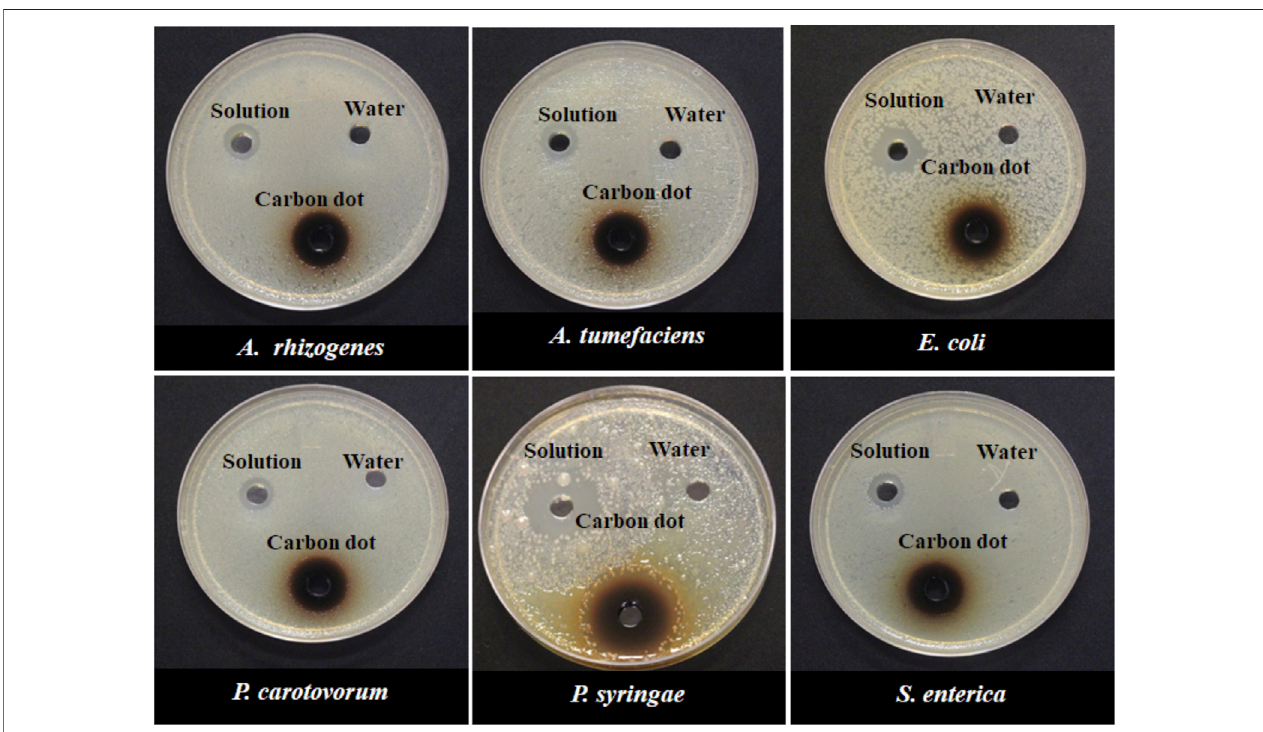
FIGURE 6 | Growth inhibition of different Gram-negative bacteria in response to 15 mg ml − 1 concentration of NH2-CDs. Water and unprepared reactants were used as control.